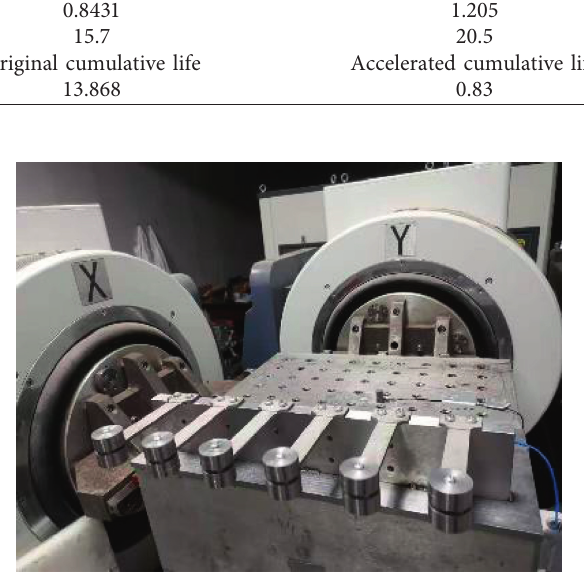
Figure 15: Original fatigue life test countertop arrangement.